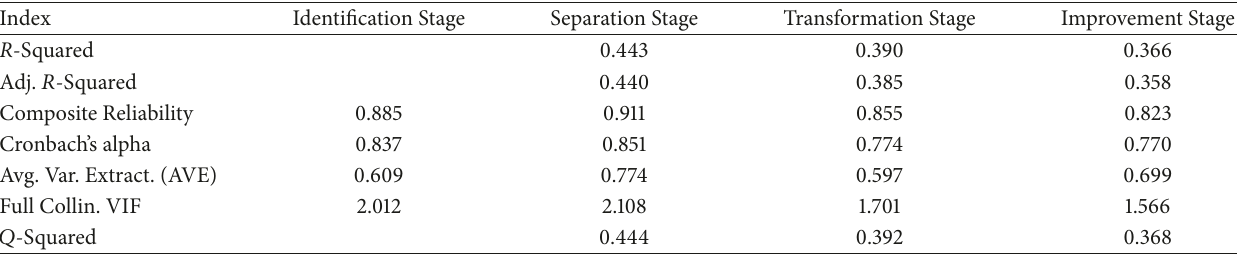
Table 3: Survey validation.